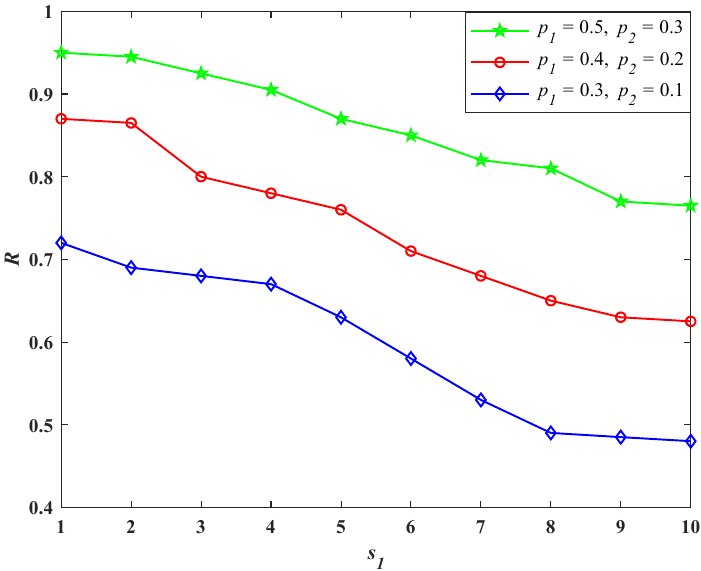
Figure 4. Sensitivity analysis of system reliability on s 1 under different p 1 and p 2 .